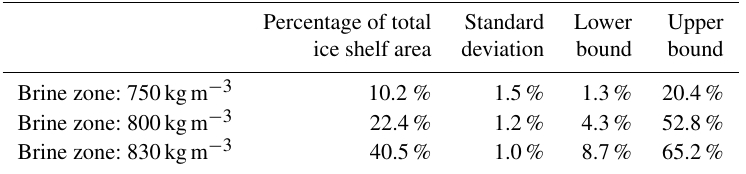
Table 1. Percentage of total Antarctic ice shelf area covered by potential brine zone. For each of the three threshold densities we provide the mean percentage area of Antarctic ice shelves where permeable firn lies below sea level, calculated using five different surface elevation models. Lower and upper bounds were calculated using maximum uncertainties in the firn air content (Ligtenberg et al., 2011) and Bedmap2 surface elevation data set (Griggs and Bamber,